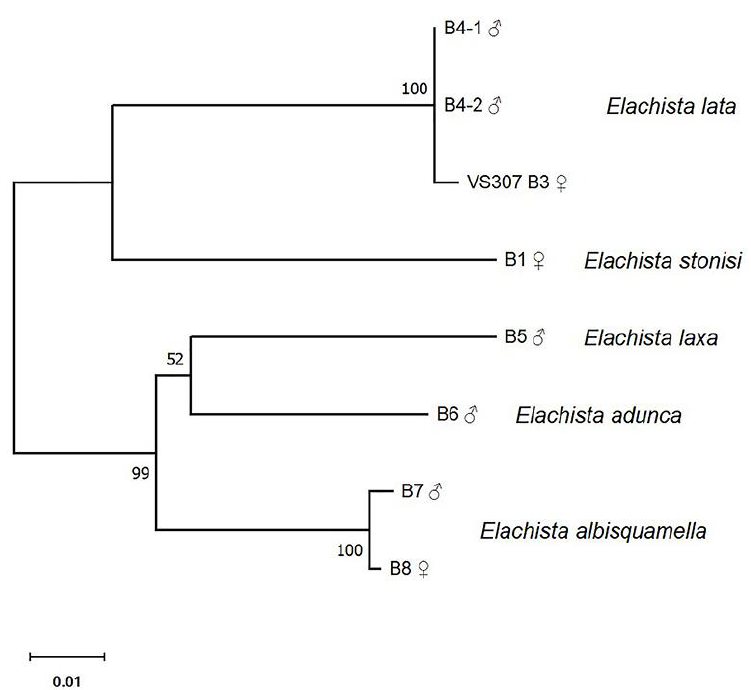
Neotropical species of the E. praelineata species group formed two major clusters in a Neighbour-Joining tree based on partial COI sequences (Figure 5). One cluster consists of sequences belonging to two species, E. lata and E. stonisi sp. nov., and the other one is made up of sequences representing samples of E. albisquamella , E. laxa , and E. adunca . Se- quence distances corresponded well with morphological data: morphologically similar species showed lower values of uncorrected p-distances.